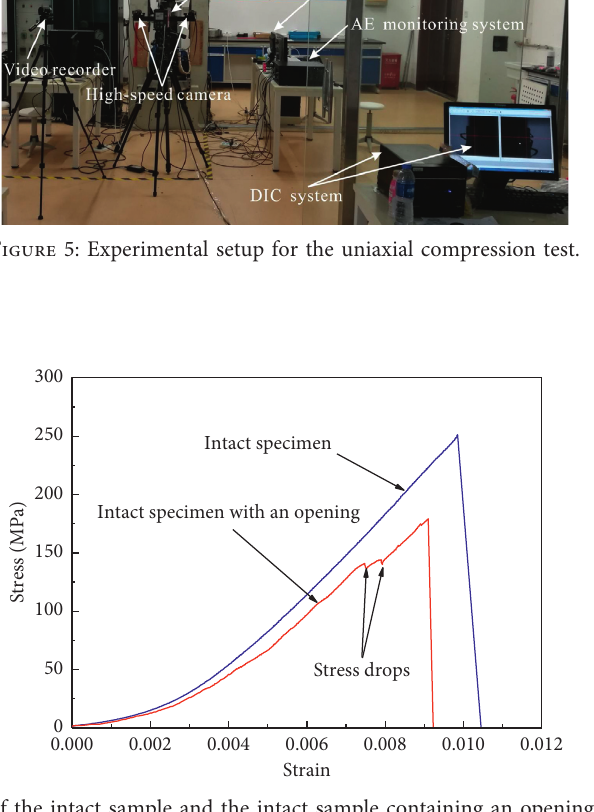
Figure 6: Stress-strain curves of the intact sample and the intact sample containing an opening under uniaxial